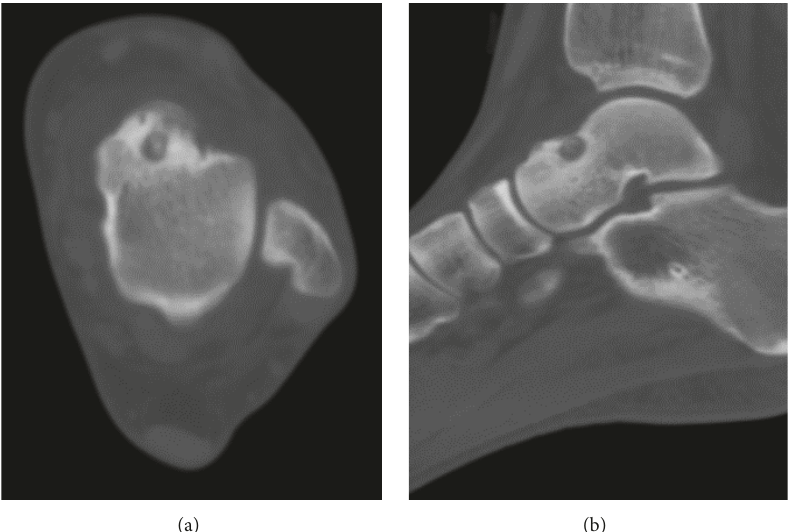
Figure 2: Axial (a) and sagittal (b) computed tomography images of the left ankle showing central calcification within a radiolucent lesion of the talar neck.